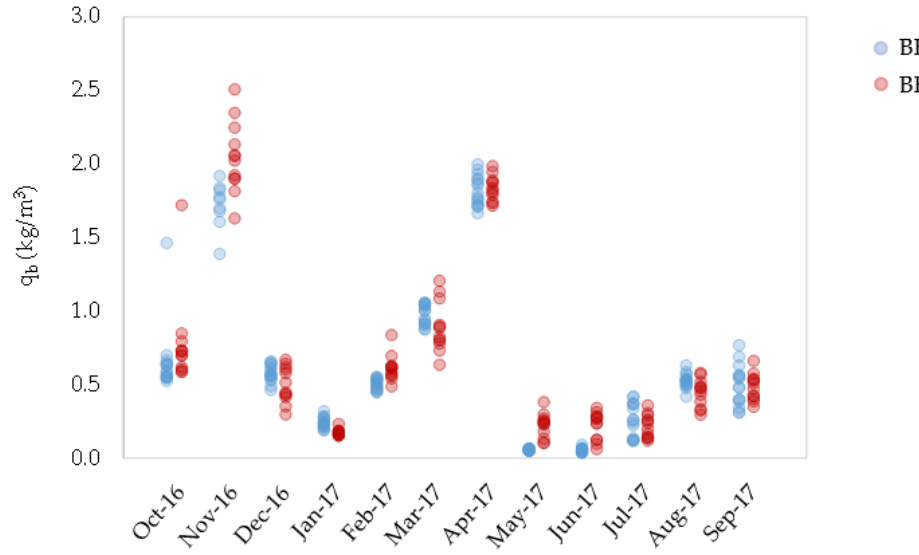
Figure 8. Comparison of sediment transport rates at BH2 and BH3 in one year of sampling sediment.